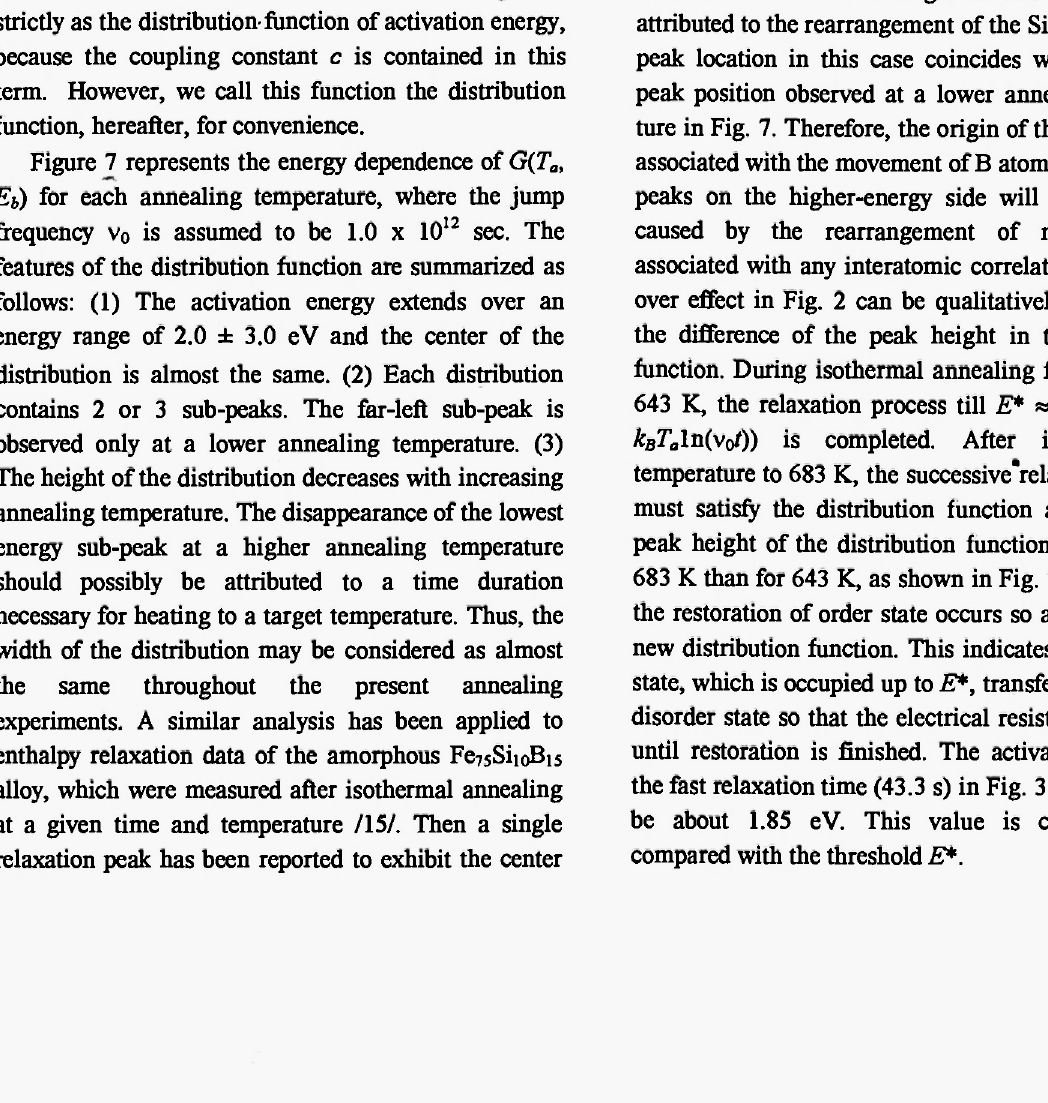
Fig. 7: Energy spectrum of the relaxation time for various annealing temperatures. They were calculated by following the AES